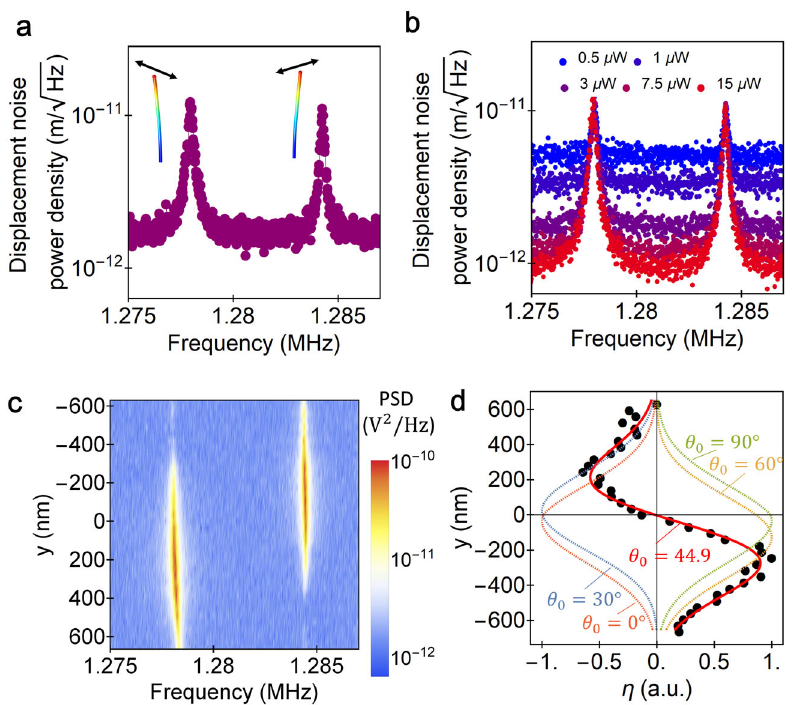
Fig. 3 Characterization of two-mode mechanical spectra and their sensitivity in thermal motion by balanced homodyne interferometry. a Two-mode power spectral density of thermal motion observed by balanced homodyne interferometry with an optical probe power of 3 μ W. The insets show the fundamental fl exural mode calculated by the fi nite element method (the color code corresponds to the amount of displacement, and the black vectors depict the vibration directions). b Two-mode power spectral density of thermal motion with different optical probe powers. The lowest noise fl oor level, ffiffiffiffiffiffi p — S ¼ 8 : 2 ´ 10 (cid:2) 13 m = — , was achieved with the optical probe power of 15 μ W. c Two-mode power spectral density of thermal motion with respect Hz floor to y coordinate. d Normalized difference between integral of power spectral density for modes η ( y ) with respect to y coordinate. The black dots show the experimental data and the red solid curve shows the fi tted curve with θ 0 = 44.9° and an tilted sweep angle ϕ 0 = 1.2°. η has completely different pro fi les with respect to the initial angle θ 0 between the x -axis and the vibrating direction of a mechanical mode in the nanowire (curves with θ 0 = 0°, 30°, 60°, and 90° are shown with ϕ 0 =